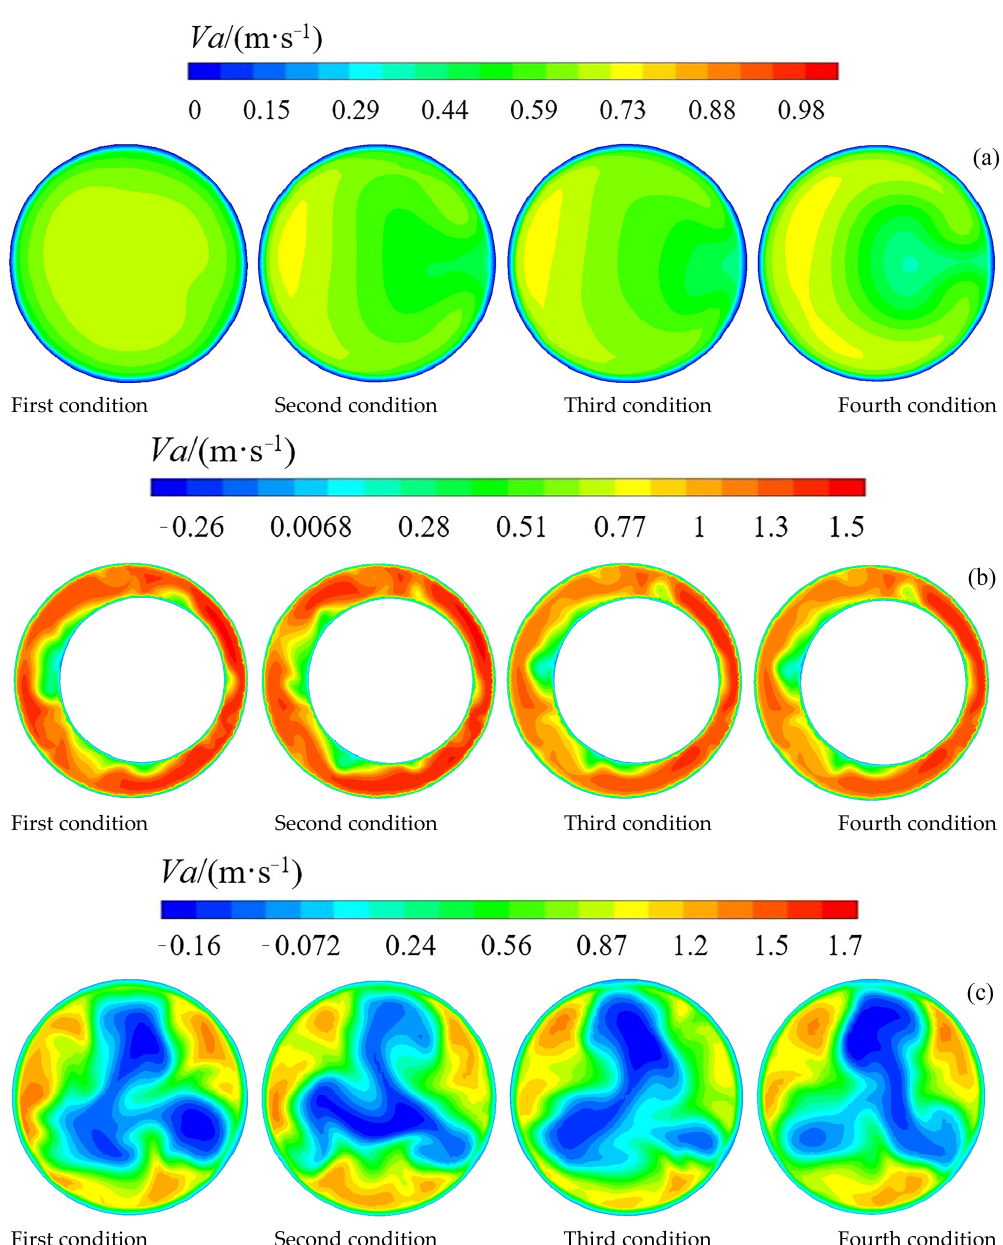
Figure 8. The axial flow velocity distribution cloud map of the characteristic section when the pipeline truck starts at different positions of the pipe bend (the conditions meaning the centroid of the wheeled capsule had angle locations of θ ): ( a ) upstream of the wheeled capsule; ( b ) gap zone between the capsule and the pipe; ( c ) downstream of the wheeled capsule.